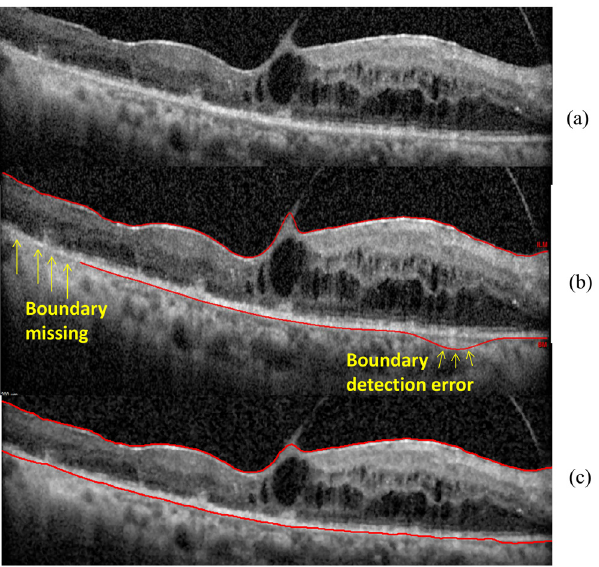
Fig 11. Algorithms performance in the B-scan obtained from the patient with diabetic macular edema. (a) The raw OCT B-scan. (b) The boundaries delineated by the built-in Spectralis SD-OCT software for the ILM and RPE-CH. The yellow arrows are indicating the boundary detection errors by the built-in software of the Spectralis device. (c) The boundaries delineated by OCTRIMA 3D for the ILM and the RPE-CH.